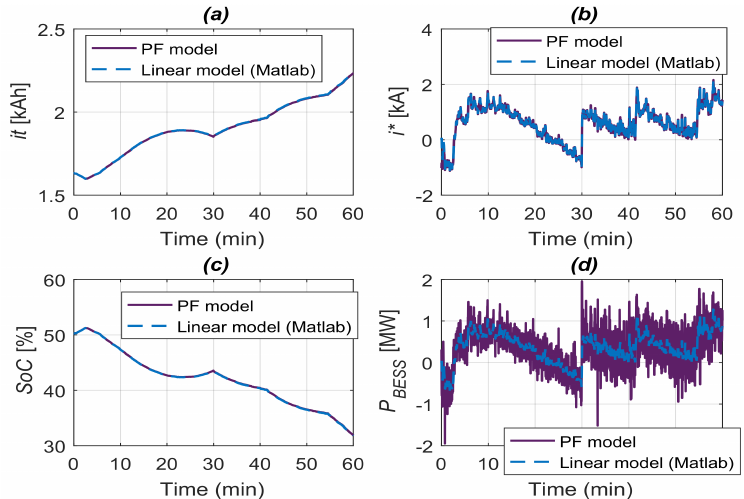
Figure 15. Hybrid power plant (HPP) modeling: inputs and outputs. ( a ) Integral current it , ( b ) Filtered current i ∗ , ( c ) SOC and ( d ) BESS active power.